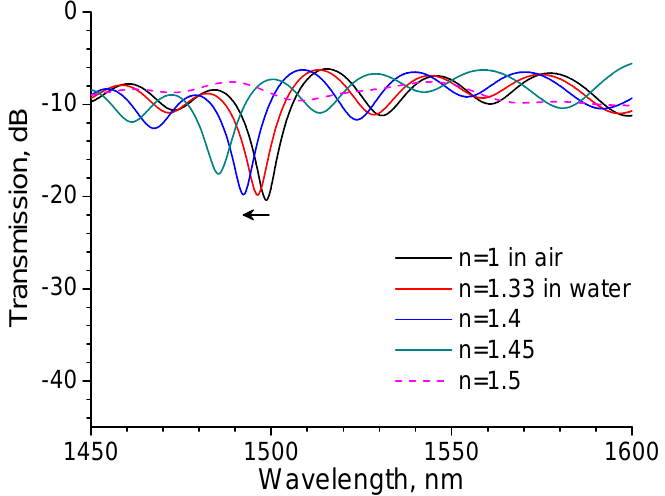
Figure 7. Transmission spectra of a 20-mm-long bent LPG surrounded by a medium having a refractive index ranging from 1 to